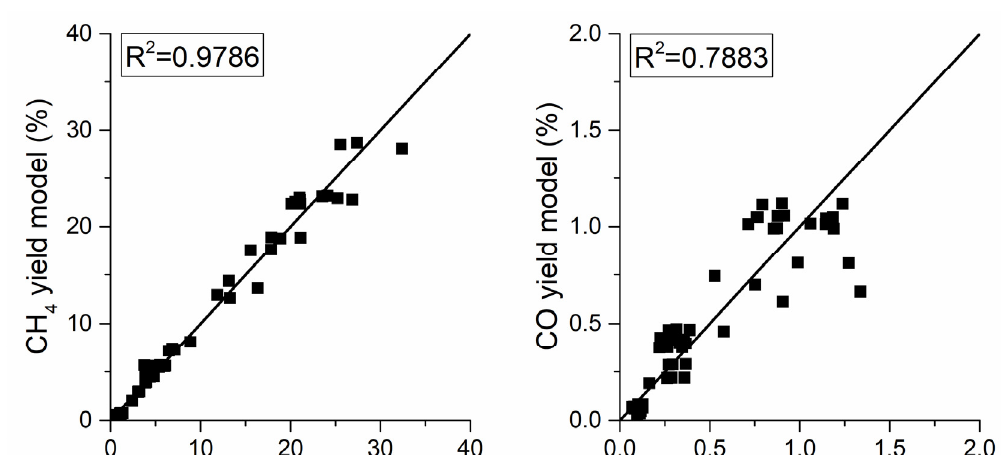
Figure 9. Parity plot using the LHHW model for the CH 4 yield (left) and the CO yield (right).